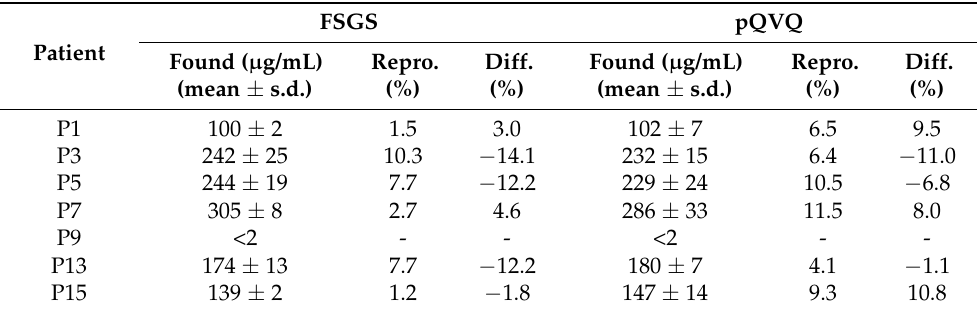
Table 9. Pre-analytical stability of rituximab at − 20 ◦ C over three months and autosampler stability (+4 ◦ C, 72 h), calculated with the pQVQ peptide. Data obtained via LC-MS/MS assay. FSGS pQVQ Patient Found ( µ g/mL) (mean ±